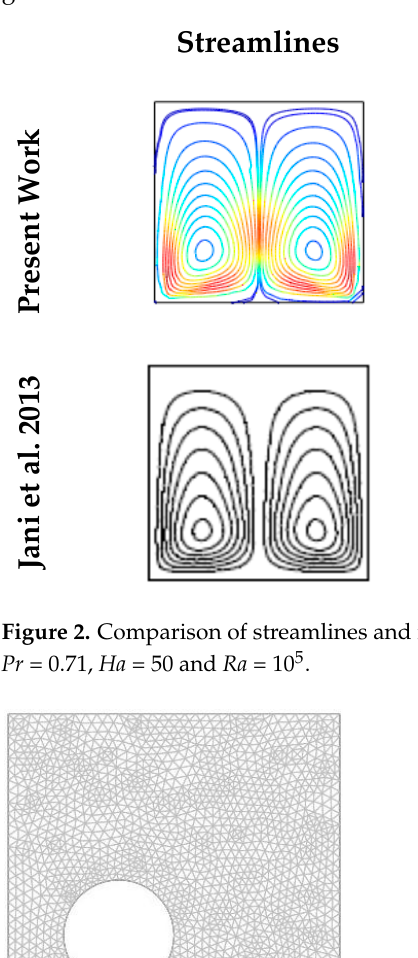
Table 1. Grid sensitivity tests at Pr = 0.71, Ha = 100 and Ra = 10 5 .